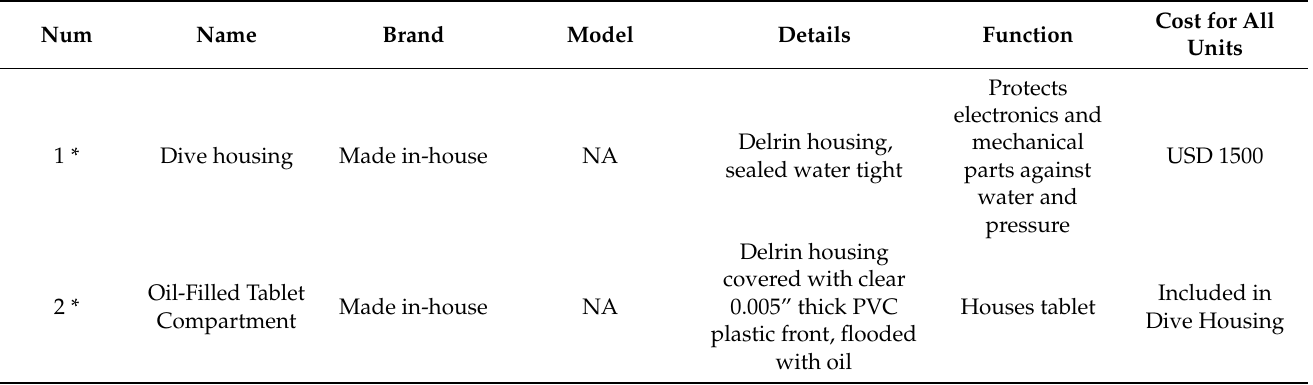
Figure 1. Diagram of DISCO II showing the ( A ) front and ( B ) back of the instrument alongside photos of the ( C ) front and ( D ) back. Numbers correspond with Table 1 and point to essential components in DISCO II. Table 1. List of DISCO II components with description of the brand, model, details, function inside the instrument, and cost for all units. Numbers (Num) correspond with the components shown in Figure 1. The “*” indicates components that are updated from DISCO I to DISCO